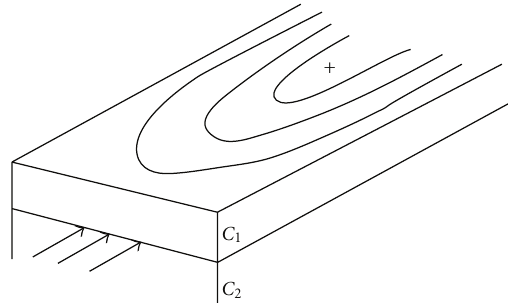
Figure 1: Representation of a self-potential anomaly that is pro- duced by a horizontal subsurface flow at the contact of two layers (Schiavone and Quarto [12]).